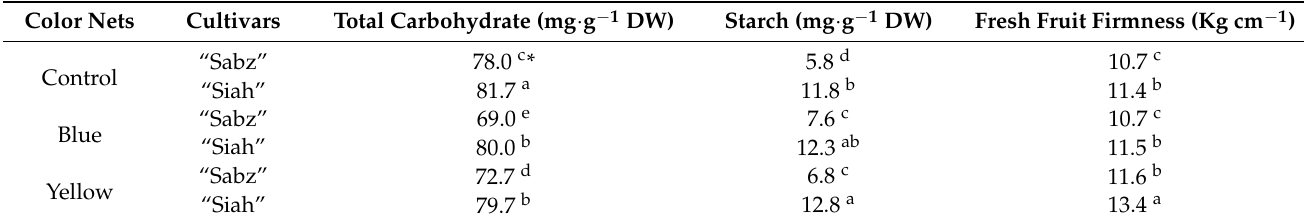
Table 3. The combined effects of color nets and fig cultivars on total carbohydrate and starch content in the dried figs and fruit firmness in fresh